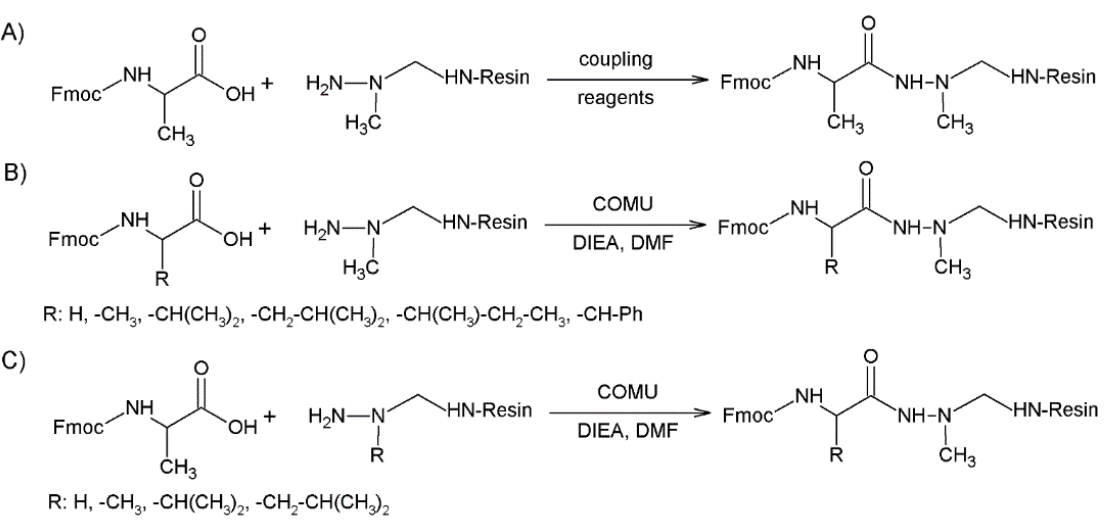
Scheme 1. Probing the efficiency of amino acid coupling to the azaamino acid in the sequence. ( A